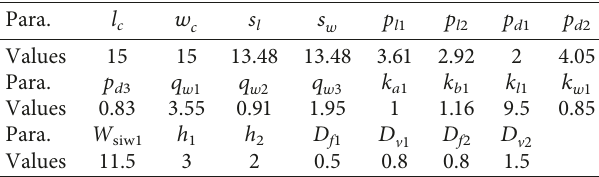
Table 1: Dimensions of the proposed antenna element (unit: mm).